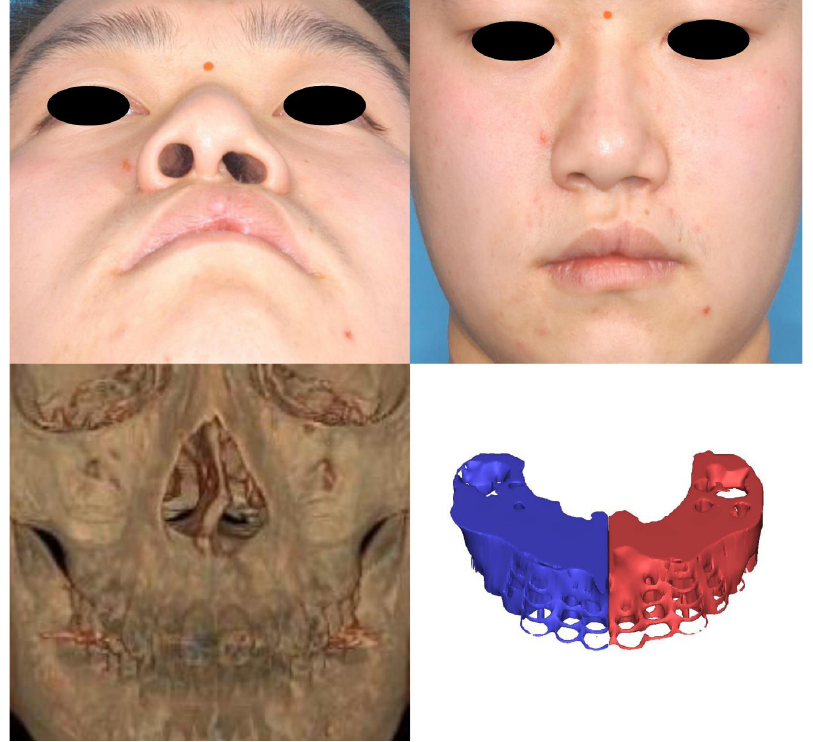
Figure 6. Case 1. A 13-year-old male patient with microform cleft lip. ( upper, left ) Worm’s-eye view. The nostril is flat and wide with a gentle incline on the cleft side compared with the normal side. ( upper, right ) Frontal view. The philtrum is depressed, and a notch is evident on the vermilion- cutaneous junction on the cleft side. The columella deviates to the contralateral side. ( lower, left ) Anterior view of the 3D-reconstructed computed tomography scan. A bony notch on the anterior nasal crest is seen. ( lower, right ) 3D-reconstructed image of the alveolar bone using Mimics software. The alveolar volume was 5453.97 mm 3 on the cleft side and 5731.04 mm 3 on the normal side. The volume was smaller on the cleft side, with a difference of 277.07 mm 3